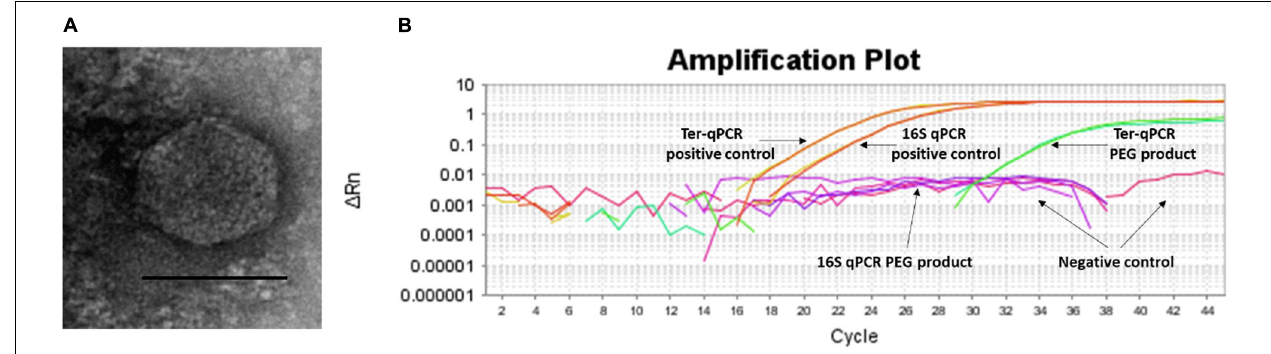
FIGURE 6 | Spontaneous prophage release from B. burgdorferi B31 cultures. (A) : Image of the phage-like particles visualized during TEM analysis of the PEG purified cell-free culture filtrates. (B) : DNA extracted from the PEG product tested positive during the Ter-qPCR, but negative to the 16S qPCR, indicating the spontaneous release of cp32 prophages. 1 ng of DNA from B31 was used as a positive control (as annotated in panel B ).